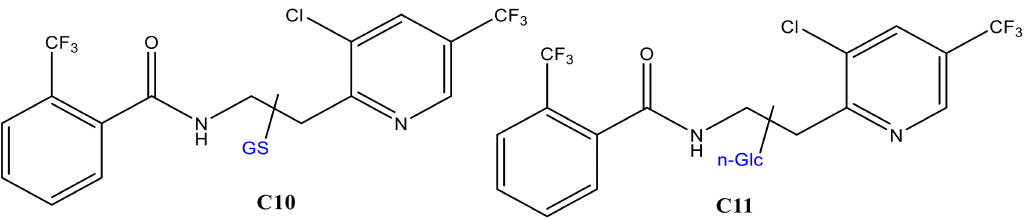
Figure 8. GSH (C10) and glucoside (C11) conjugates of monohydroxyl